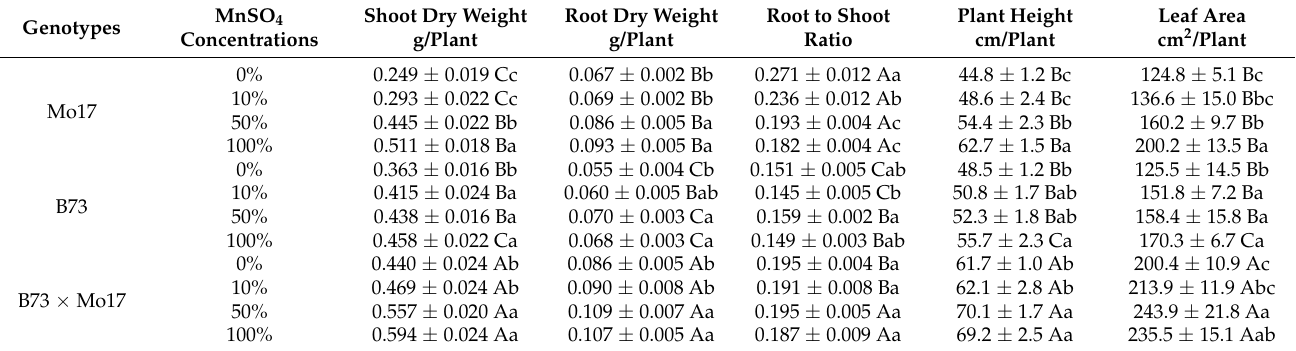
According to the LSD test different capital letters: significant difference between genotypes ( p < 0.05); different lowercase letters: significant difference between MnSO 4 treatments ( p < 0.05). Data represent the mean ± standard deviation ( n =